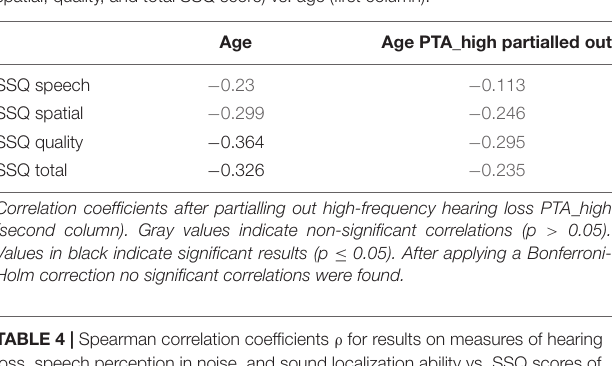
TABLE 4 | Spearman correlation coefficients ρ for results on measures of hearing loss, speech perception in noise, and sound localization ability vs. SSQ scores